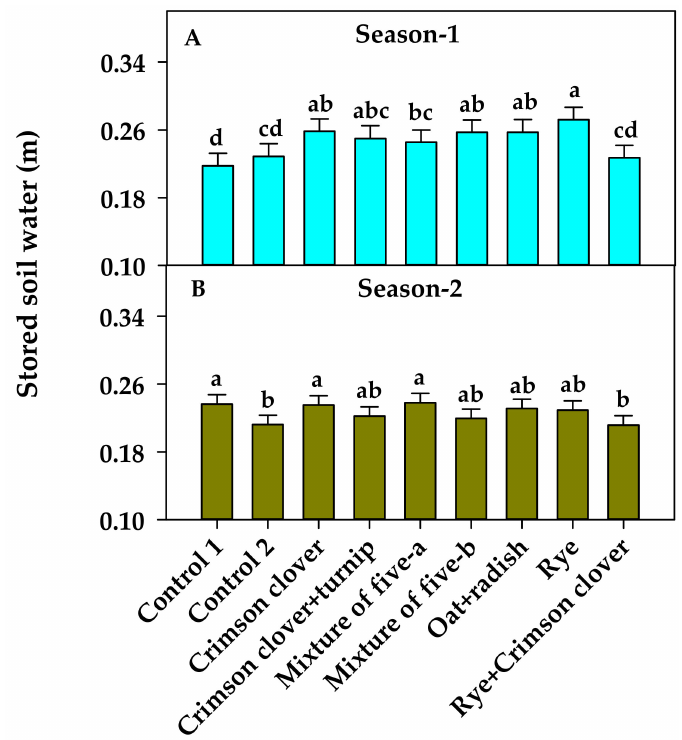
Figure 5. Total stored soil water in 60 cm depth at ( A ) 37 days after cover crop termination in season-1 (2 August 2017) and ( B ) 35 days after cover crop termination in season-2 (11 July 2018). Bars (least squares means) with di ff erent letters are significantly di ff erent according to the least significant di ff erence (LSD) test at α = 0.05. Control treatments were fallow with herbicide application (control-1) and fallow without herbicide application (control-2). Mixture of five-a was a combination of Austrian winter pea, rye, crimson clover, hairy vetch, and oat. Mixture of five-b was a combination of oat, wheat, crimson clover, radish, and